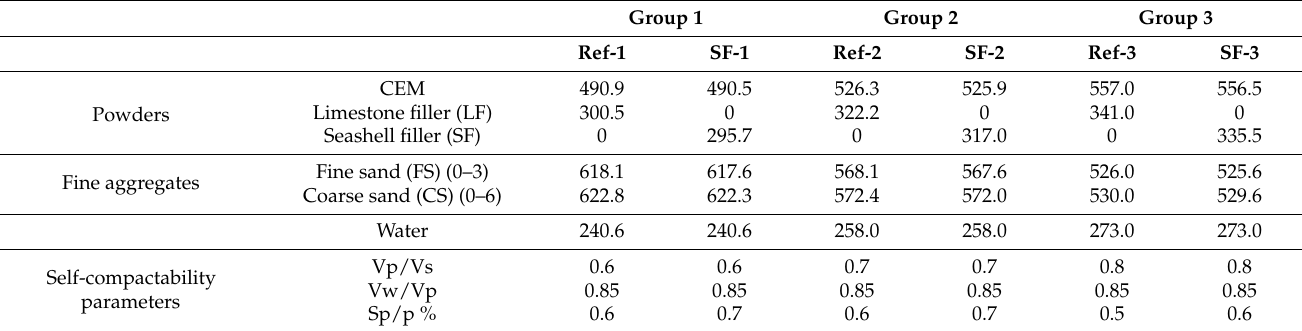
Table 1. Nomenclature, mixing proportions (kg/m 3 ) and self-compactability properties of the self- compacting mortars